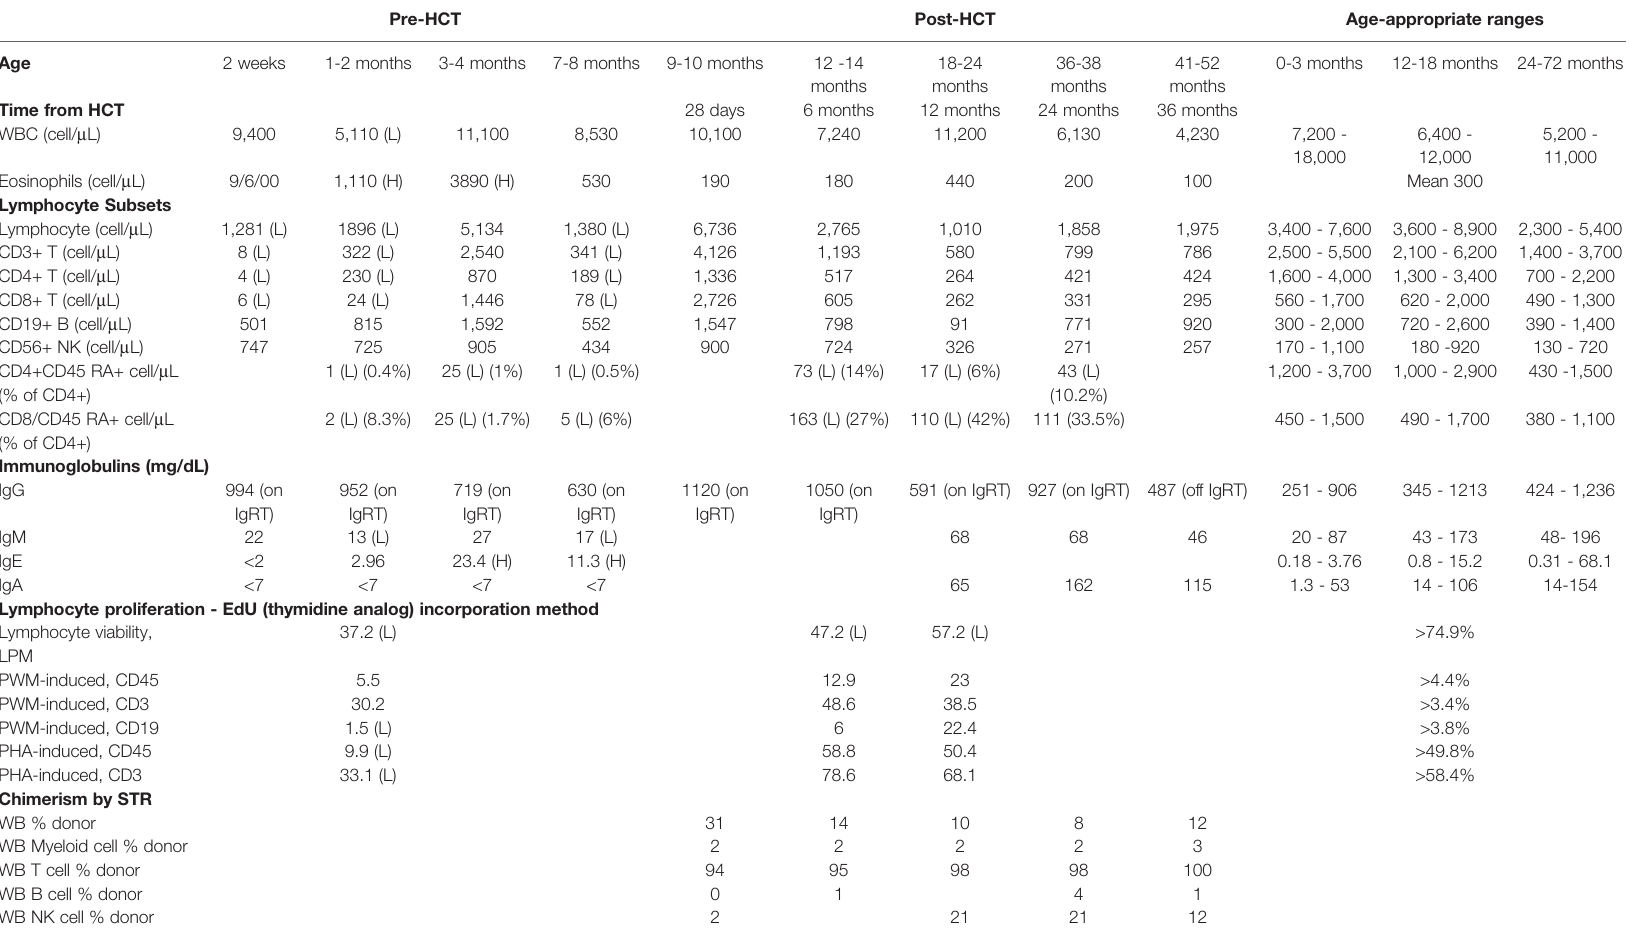
TABLE 1 | Immunologic phenotyping and post-HCT monitoring over